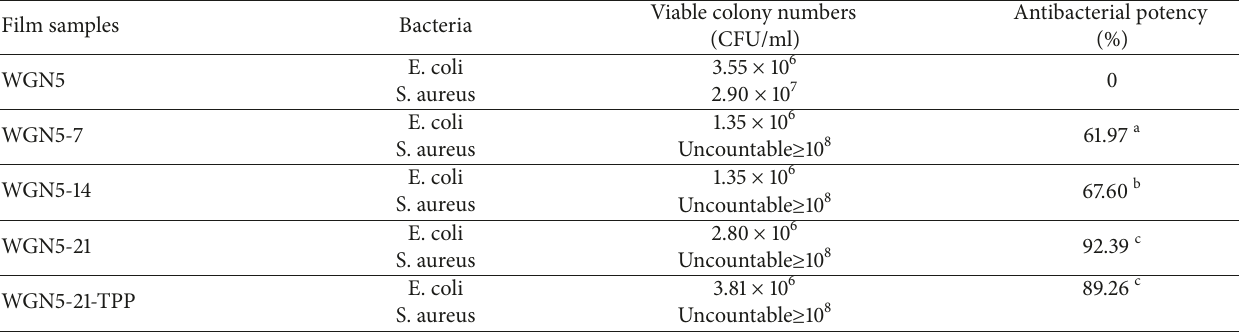
Table 3: Antibacterial properties of WPI-gelatin-MMT-OPE films. Means within the column with the same letters are not significantly different (p <